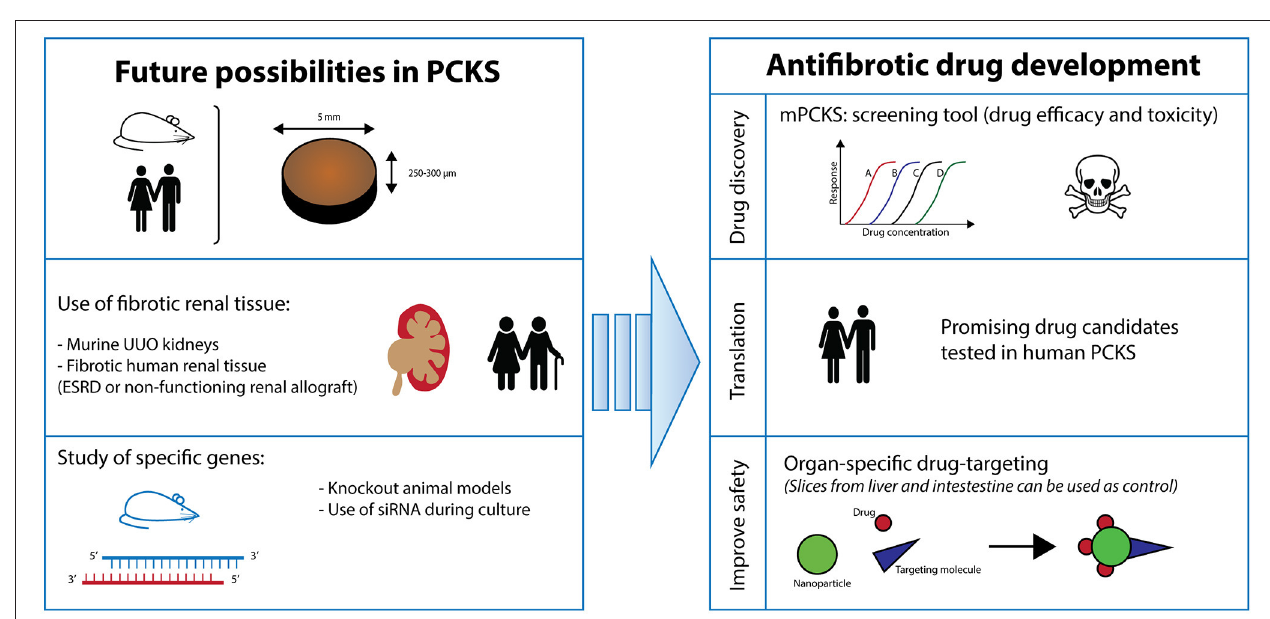
FIGURE 6 | Future perspectives. PCKS, precision-cut kidney slices; ESRD, end-stage renal disease; UUO, unilateral ureteral obstruction.